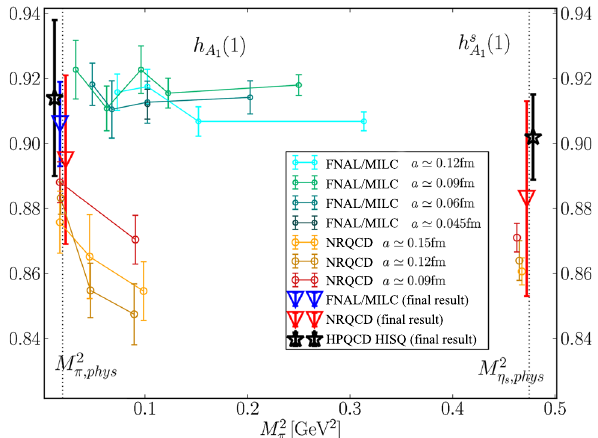
Fig. 1 Plot taken from Ref. [24] showing the comparison of lattice ( 1 ) (left side) and h s ( 1 ) (right side). Raw results QCD results for h A A 1 1 ( 1 ) arefrom[39]and[37]andareplottedasafunctionofvalence for h A 1 (= sea) light quark mass, given by the square of M π . On the right are ( 1 ) from [39] plotted at the appropriate valence mass points for h s A 1 for the s quark, but obtained at physical sea light quark masses. The ( 1 ) from [37], with its full error bar, is given by the final result for h A 1 inverted blue triangle. The inverted red triangles give the final results ( 1 ) and h s ( 1 ) from [39]. The HPQCD results of [24] are given for h A A 1 1 by the black